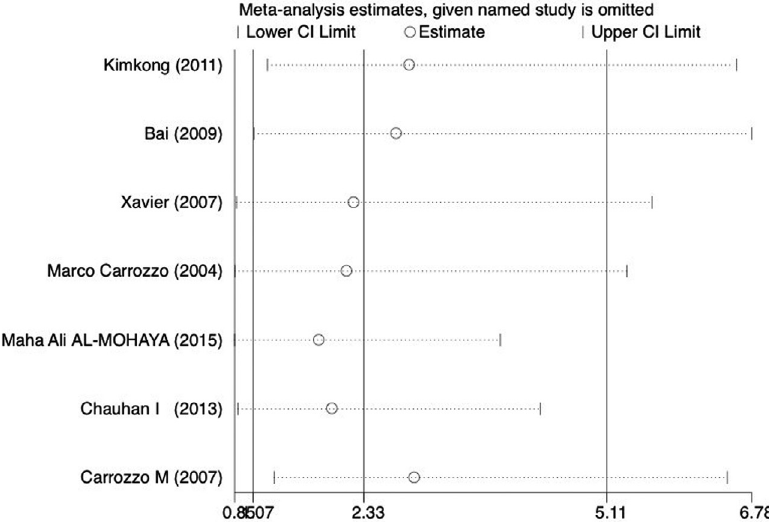
Figure 5- Sensitivity analyses. Effect of individual studies on the pooled OR under allele comparison for TNF α -308G/A polymorphism in OLP patients (random-effects model). Pooled odds ratios and 95% confidence intervals for excluding each data set in the meta-analysis. The vertical axis at 2.33 indicates the overall OR, and the two vertical axes at 1.07 and 5.11 indicate the 95% CI. Every hollow round indicates the pooled OR when the left study was omitted in a meta-analysis with a random